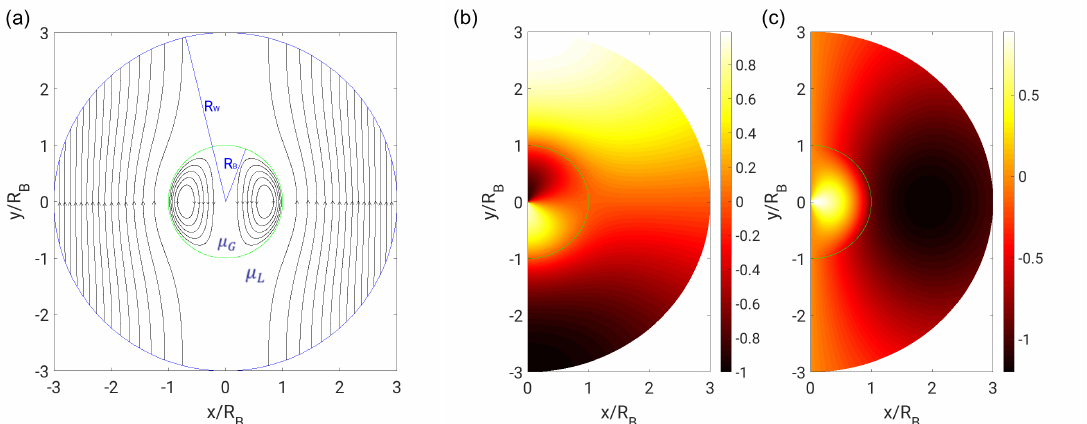
Figure 3. ( a ) Streamlines; ( b ) radial velocity u r ; and ( c ) circumferential velocity u θ in the bubble case ( ξ = 0.0182) with near-field boundary conditions ( r W = 3 r B